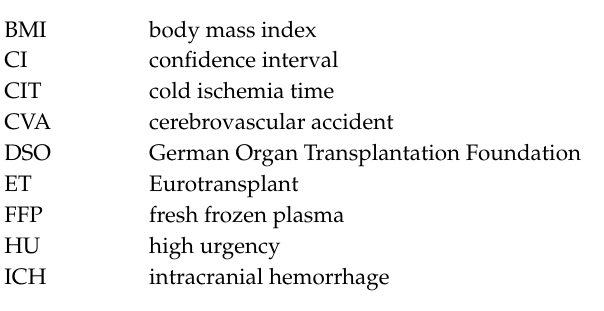
Figure S1: Patients included in the study, Figure S2. Development of established risk scores for liver transplantation after the implementation of MELD-based liver allocation, Figure S3. Development of 5-year patient survival from 2002 to 2012 in the whole Eurotransplant